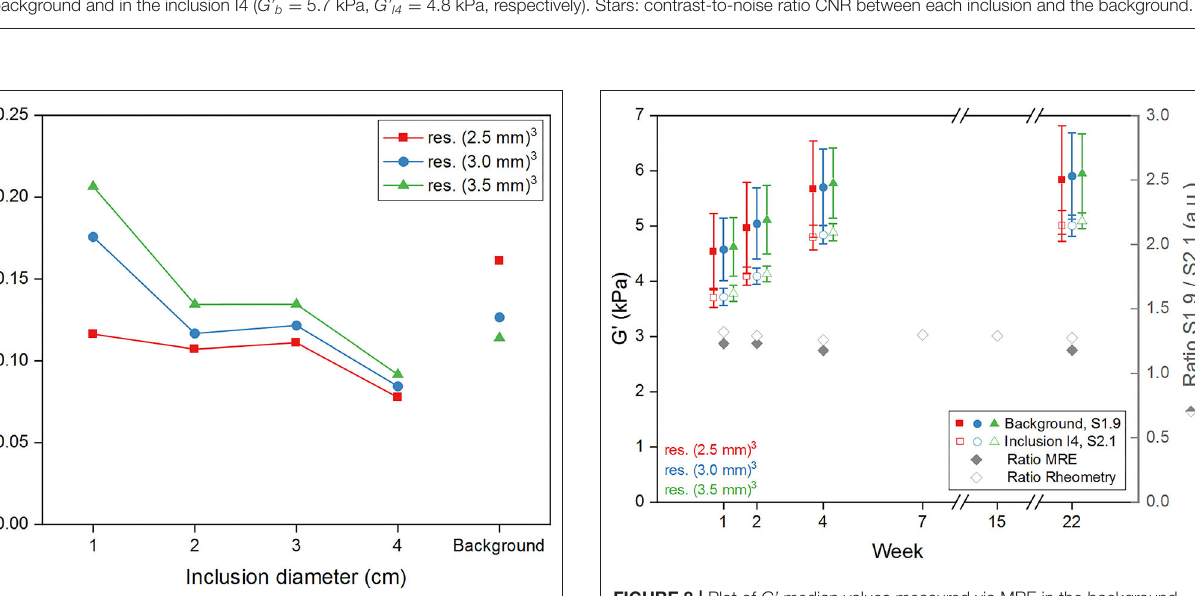
FIGURE 6 | MRE results 4 weeks after fabrication. (A) Example of a reconstructed 3D dataset at the central slice and its sections along the indicated lines A-A and B-B at 3-mm resolution (red circles: position of the inclusions). (B) Summary of G’ values in the reconstructed voxels of the three middle slices in the different segmented regions (inclusions I1, I2, I3, I4 and background) and for the three acquired voxel sizes (red: (2.5mm) 3 , blue: (3.0mm) 3 , green: (3.5mm) 3 ). The upper and lower edges of the boxes in the boxplot represent, respectively the first and the third quartile levels; horizontal line within the boxes: median value; square: mean value; whiskers: mean ± 1 standard deviation; outliers are indicated as dots. The horizontal lines across the plot represent the median values measured at 3mm resolution in the background and in the inclusion I4 ( G’ b = 5.7 kPa, G’ I4 = 4.8 kPa, respectively). Stars: contrast-to-noise ratio CNR between each inclusion and the background.